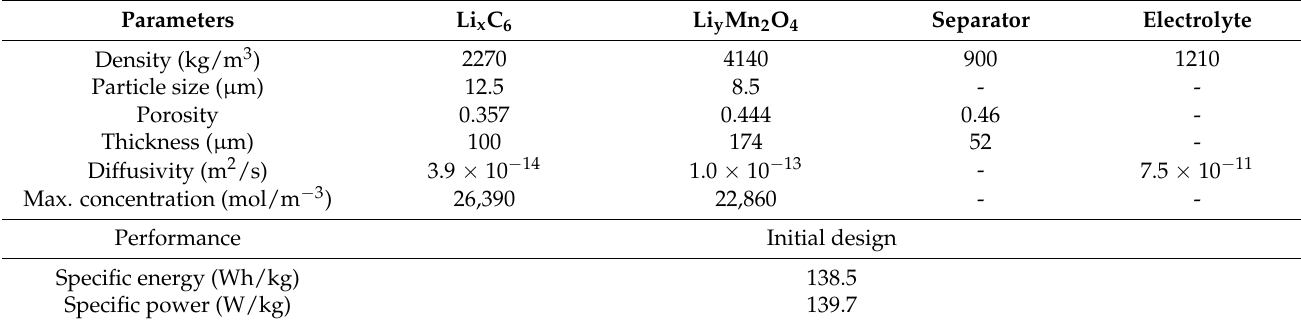
Figure 2. Comparison of simulation results of working voltage and experimental data during different discharge rates [12]. Table 1. Properties and performance of lithium-ion batteries in the initial